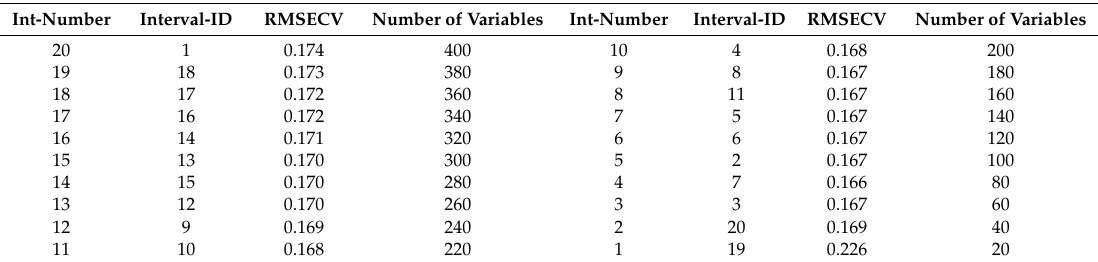
Table 2. The variable selection results of BIPLS when the spectra with 400 points are divided into 20 segments.